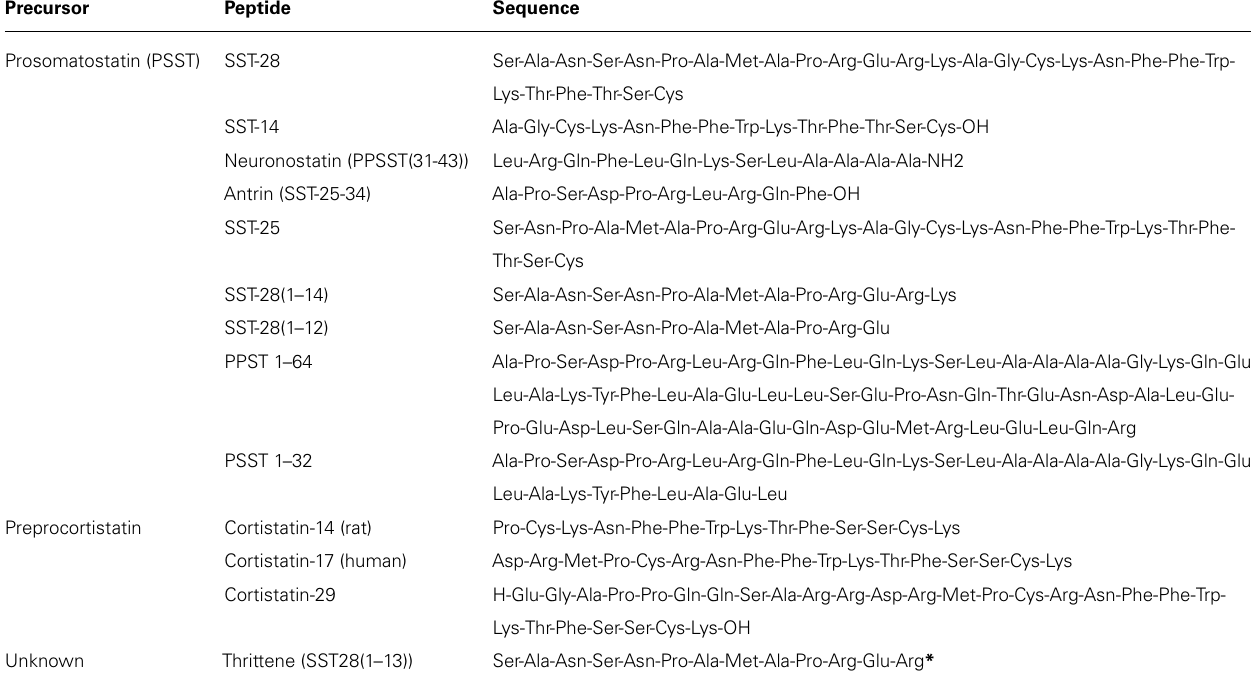
Table 1 | Endogenous somatostatin (SST) peptide sequences (*sequence not confirmed).